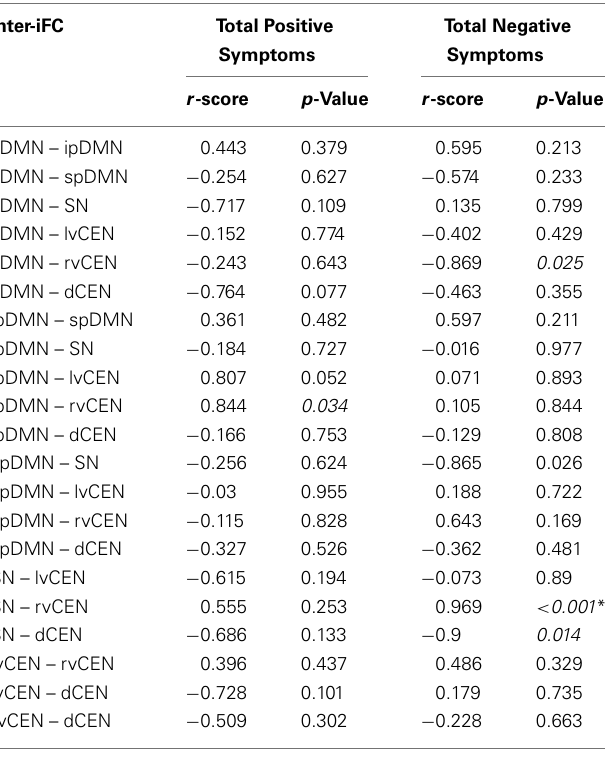
Table 6 | Partial correlations between intra-iFC in the right/leftAI within the SN and inter-iFC in patients with schizophrenia in state of remission.